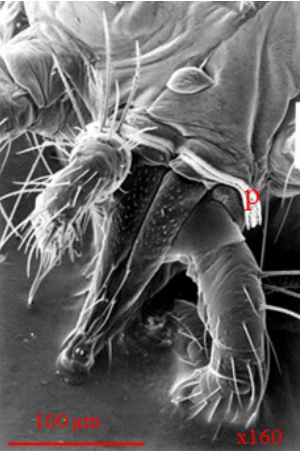
Figure 9. Scanning electron micrograph showing the distal half of the reticulated peritremes (p) flared on Anystis baccarum (Photo: Andrew G. S. Cuthbertson ©